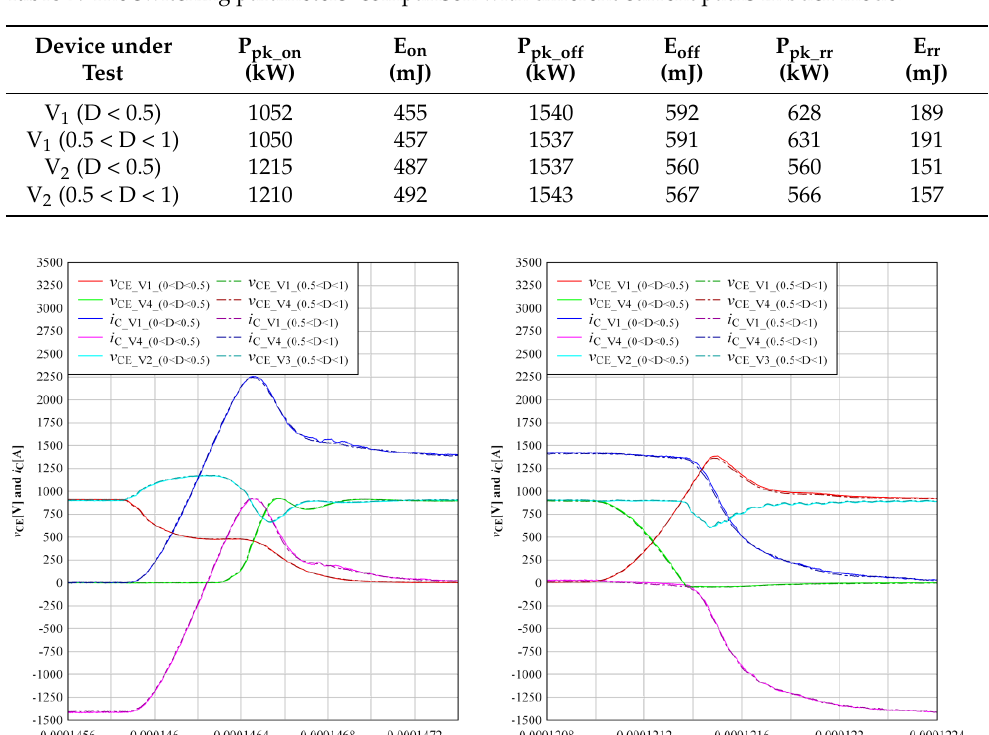
Table 7. The switching parameters’ comparison with different current paths in buck mode.